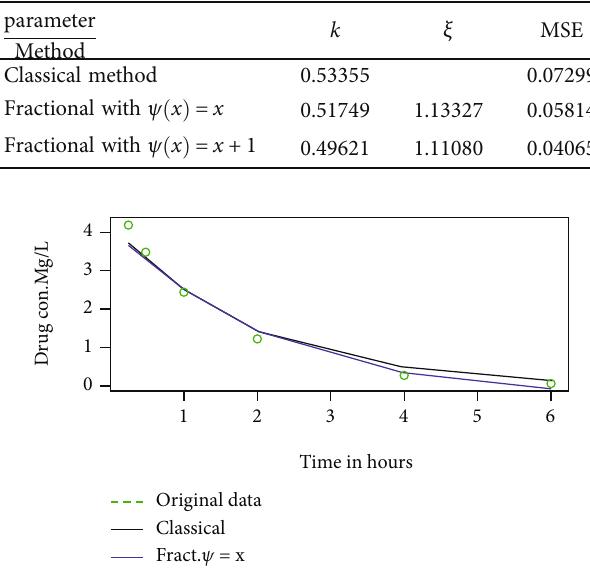
Figure 2: Original, classical, and fractional. ψ ð x Þ = x :